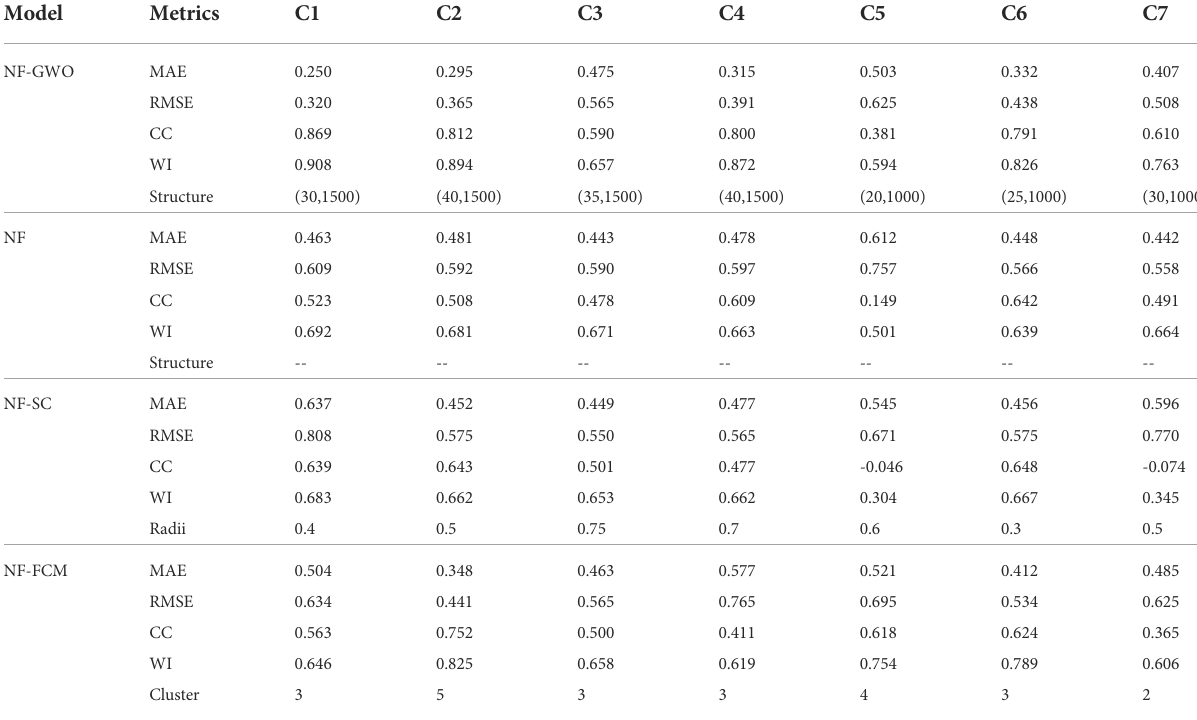
TABLE 3 Performance of models in predicting DO concentration in the test phase